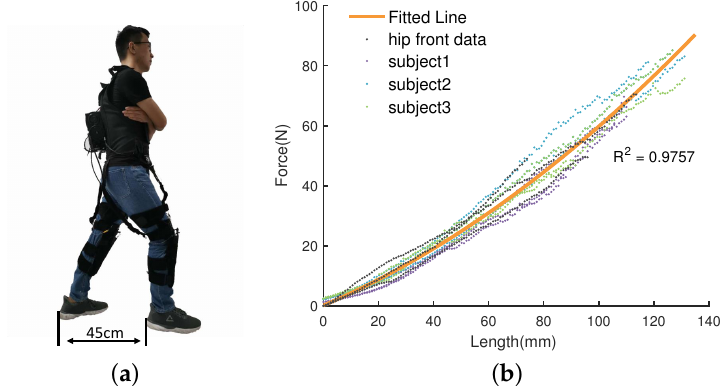
Figure 4. The stiffness model of the soft exoskeleton. Where ( a ) is the standing posture for experimenter, and the ( b ) is the result. The experiment is conducted by retracting the Bowden cable while holding the initial standing posture. The splatting is the raw data from experiment and the black dash line denotes the data that were implemented in the front of hip joint. The blue line is a fitted line with a coefficient of determination of